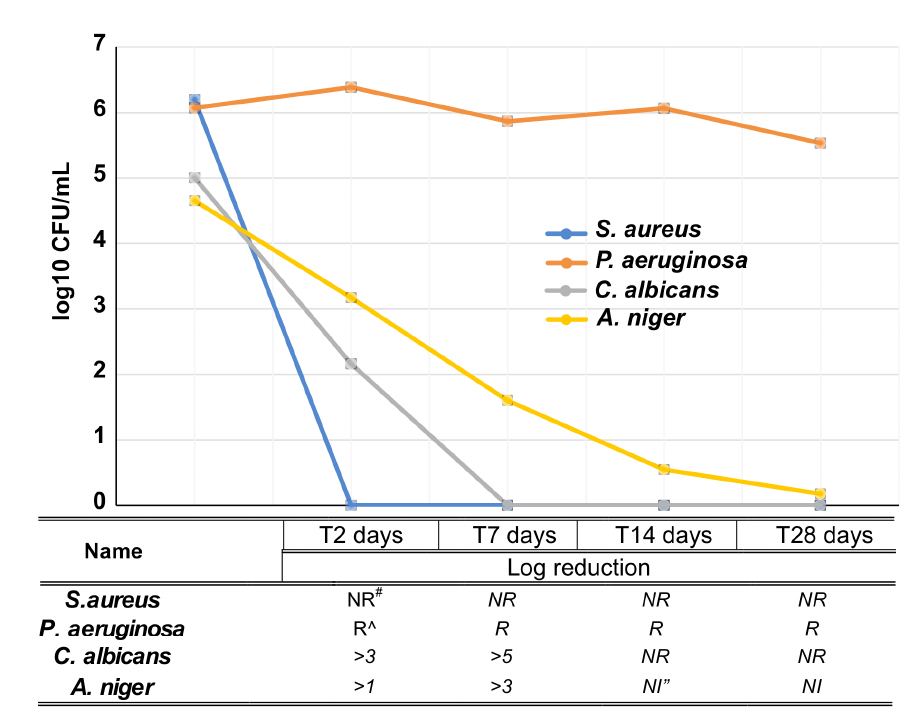
Figure 3. Challenge test over VE-TPGS CHX formulation. The VE-TPGS CHX formulation was challenged by S. aureus, P. aeruginosa, C. albicans and A. niger . At the indicated time points, inoculated solutions were collected and plated. After 2 / 3 days of incubation, colonies were counted and counts converted to log 10 values.